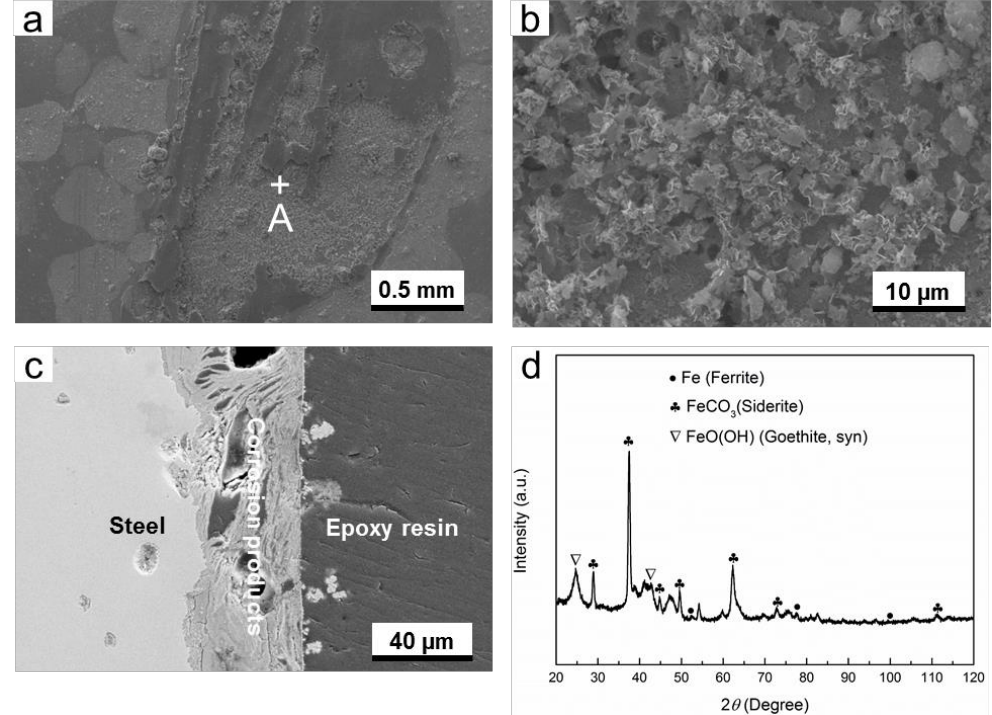
Figure 4. The characterization of corrosion products on G20 steel in gas phase in O 2 -containing environment: ( a ) SEM image of the surface of corrosion products; ( b ) the higher magnification of region A marked in ( a ); ( c ) corrosion-sectional image of corrosion product layer and ( d ) XRD pattern of the corrosion products.